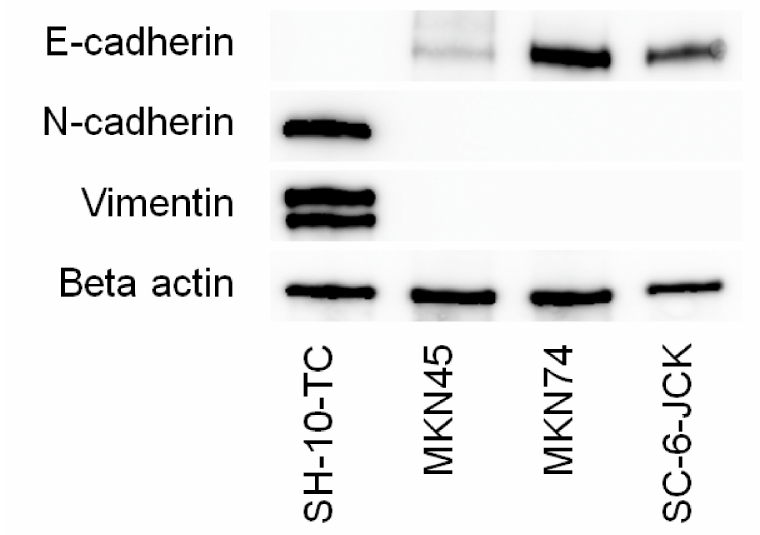
Figure 1. Phenotyping of SH-10-TC, MKN45, MKN74, and SC-6-JCK cells by immunoblot analysis. Cells were cultured for 72 h, lysed, and evaluated via Western blot analysis. SH-10-TC cells possessed a mesenchymal phenotype, with negative expression for E-cadherin and positive expression for N-cadherin and vimentin. Conversely, MKN45, MKN74, and SC-6-JCK cells possessed an epithe- lial phenotype, with positive expression for E-cadherin and negative expression for N-cadherin and